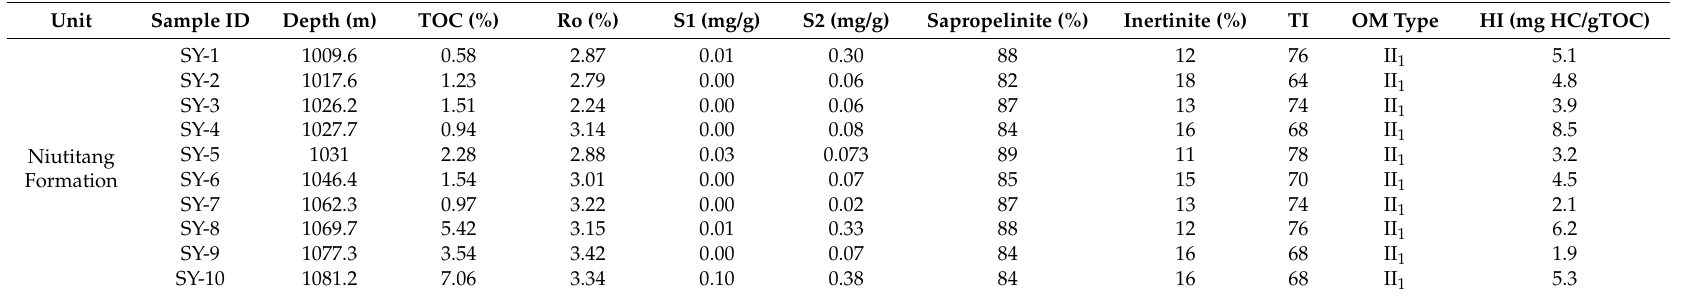
Table 1. Geochemical data and the calculated results of hydrocarbon generative